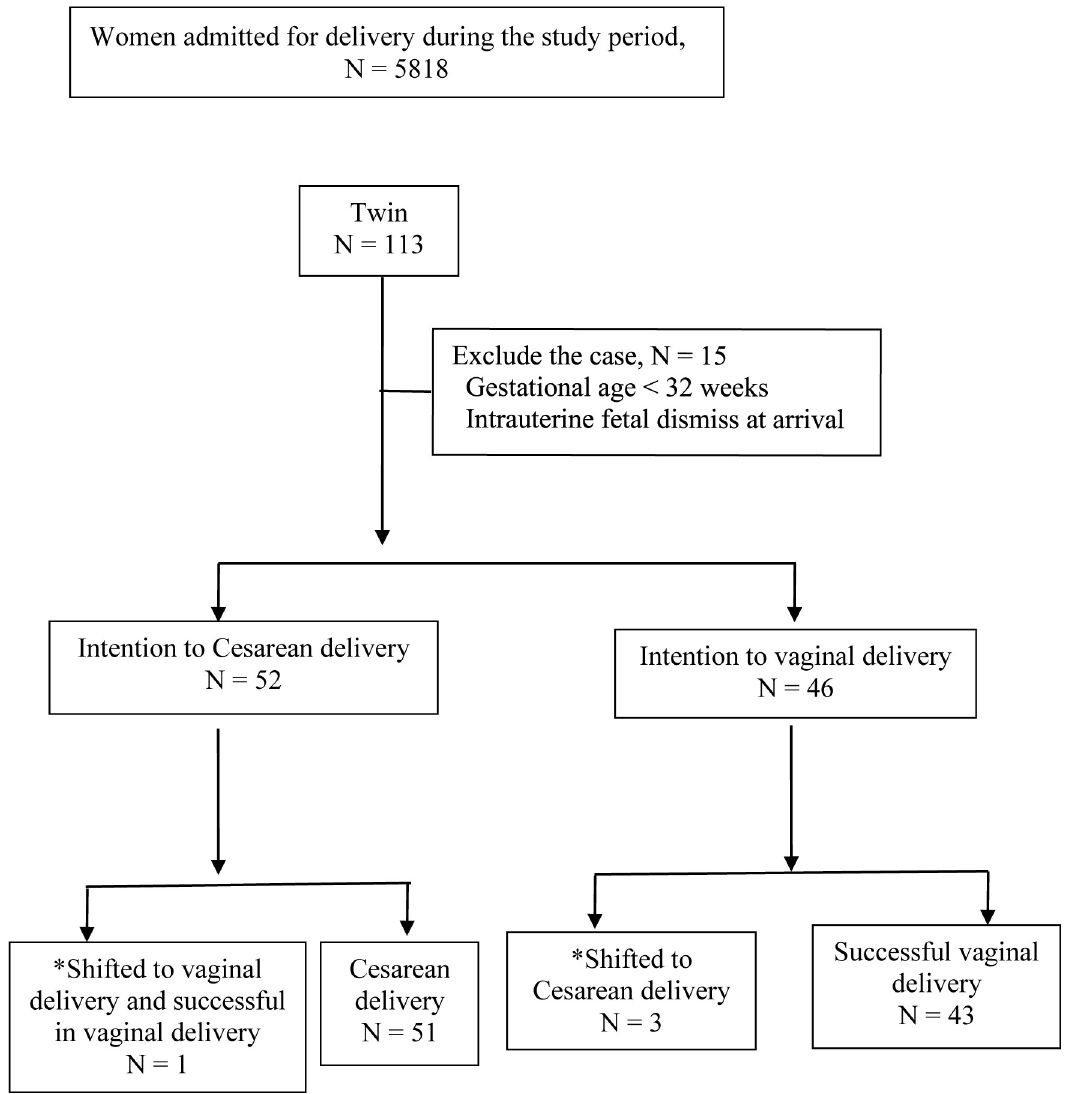
Fig 1. Flow chart of study population. � Shift of delivery modes were due to change of first fetal presentation just before delivery. Table 2 shows the outcome of the mothers and the twin fetuses in both delivery groups. There were no differences in birth weights. There were significantly longer delivery time inter- val (DTI), less amount of estimated blood loss, and shorter maternal hospital stays in the vagi- nal delivery group compared with the Cesarean delivery group. Vacuum-assisted delivery was performed in twenty vaginal deliveries. In the four cases where DTI was longer than 10 min- utes in the vaginal delivery group, the second twins required an internal conversion to change their presentations from the vertex or transverse presentation to either a footling or breech presentation for fetal extraction. There were no differences in the 1 and 5-minute Apgar scores, set at a cut-off value of 7, in the first and second twins. No neonatal death occurred in either group. TTN was only noted in fetuses of the Cesarean delivery group. There were no sig- nificant differences in the rates of other neonatal complications. As for maternal postpartum